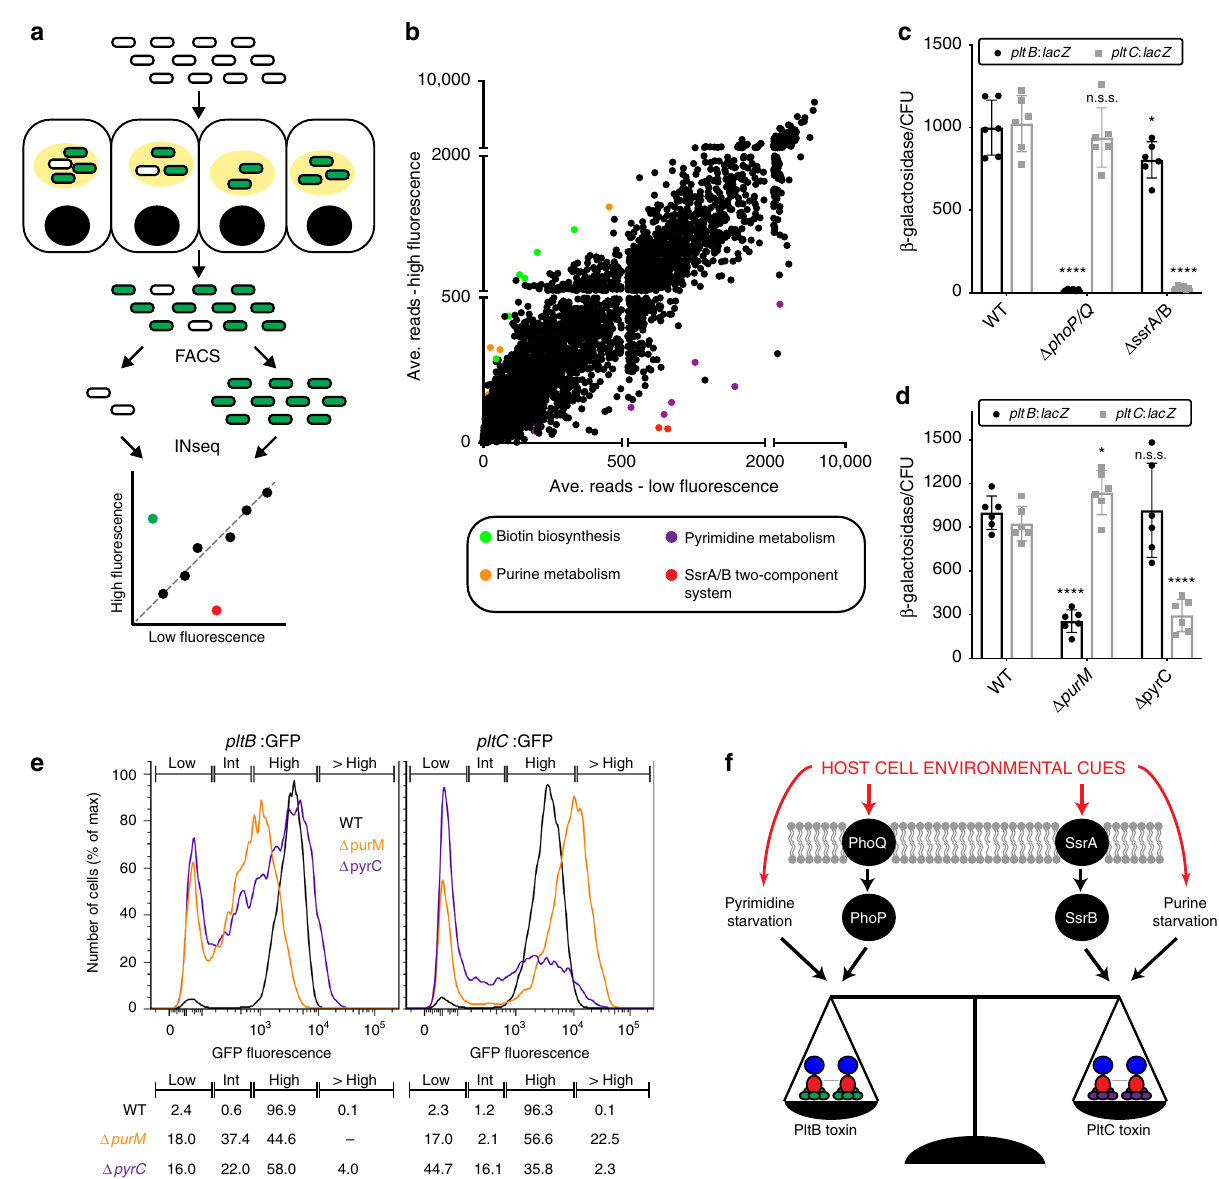
Fig. 3 Distinct regulatory mechanisms and metabolic cues control the expression of PltB and PltC. a Schematic representation of the FAST-INseq genetic screen used to identify S . Typhi genes that in fl uence pltC expression in infected host cells. A large library of random transposon mutants was generated in the S . Typhi pltC : gfp strain and used to infect Henle-407 cells. Sixteen hours post-infection the bacteria were isolated and sorted by FACS into pools exhibiting high and low GFP fl uorescence. INseq was then used to identify mutants that stimulate (green dot in plot) or reduce (red dot) pltC expression during infection. b Overview of the results of the FAST-INseq screen. Plot shows the normalized numbers of sequencing reads of transposon insertions within each S . Typhi gene in the high fl uorescence vs. low fl uorescence pools. c , d Expression levels of pltB : lacZ and pltC : lacZ reporters in infected human cells for wild-type S . Typhi (WT) and the indicated deletion mutant strains. Henle-407 cells were infected with the indicated strains for 24 h, after which the β -galactosidase activity from bacterial lysates was measured and normalized to the numbers of CFU recovered. Values indicate mean values ± S.D. for six independent determinations taken over two separate experiments. Asterisks denote statistically signi fi cant differences relative to the corresponding wild-type sample determined using unpaired two-tailed t -tests. **** p < 0.0001, * p < 0.05, n.s.s. not statistically signi fi cant. e Flow cytometry analysis of pltB : gfp and pltC:gfp expression of the indicated S . Typhi strains 24 h post-infection. Histograms show the GFP fl uorescence intensities of individual bacteria for the indicated strains. Gates were established to show the percentage of bacteria exhibiting high, low and intermediate (int) fl uorescence. The percentage of bacteria with fl uorescence intensities within these gates is shown (bottom). Gating strategy provided in Supplementary Fig. 5b. f Overview of the identi fi ed factors that differentially affect the expression of pltB and pltC and thus are likely to be important for controlling relative abundance of the two typhoid toxins produced by S . Typhi upon encountering different environments during